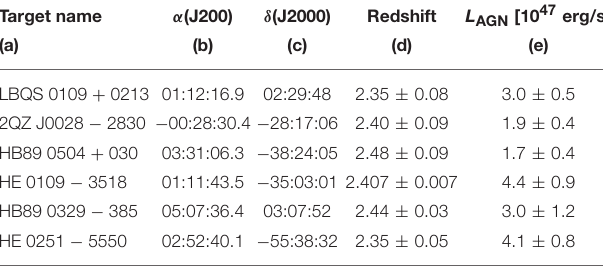
TABLE 1 | Properties of our quasar